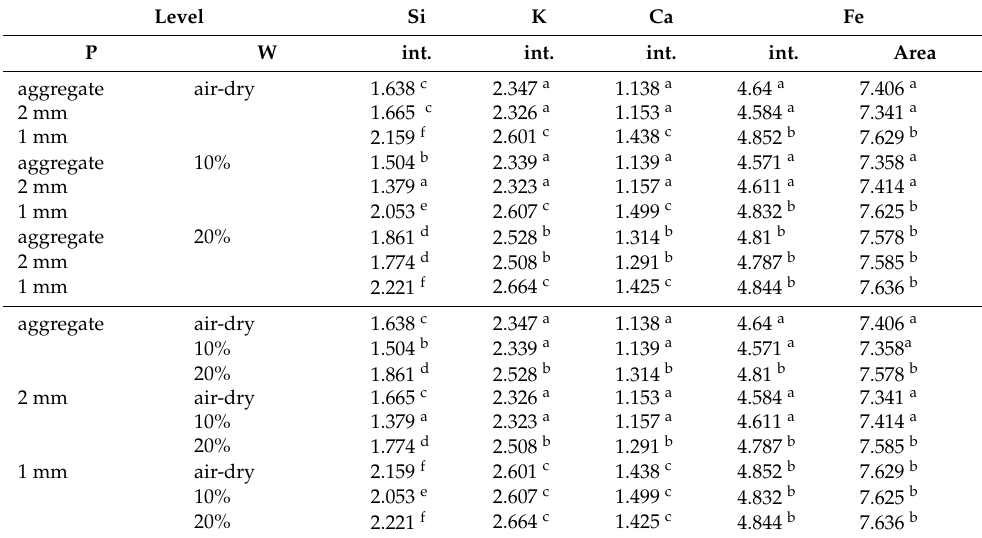
Table 4. The post hoc (LSD) pairwise comparisons of sample preparation and excitation